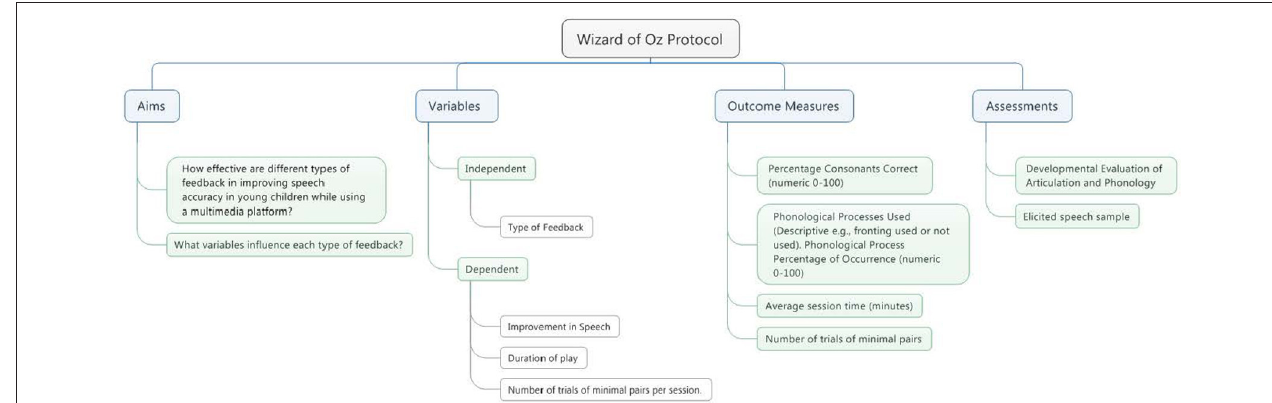
FIGURE 3 | Study design.